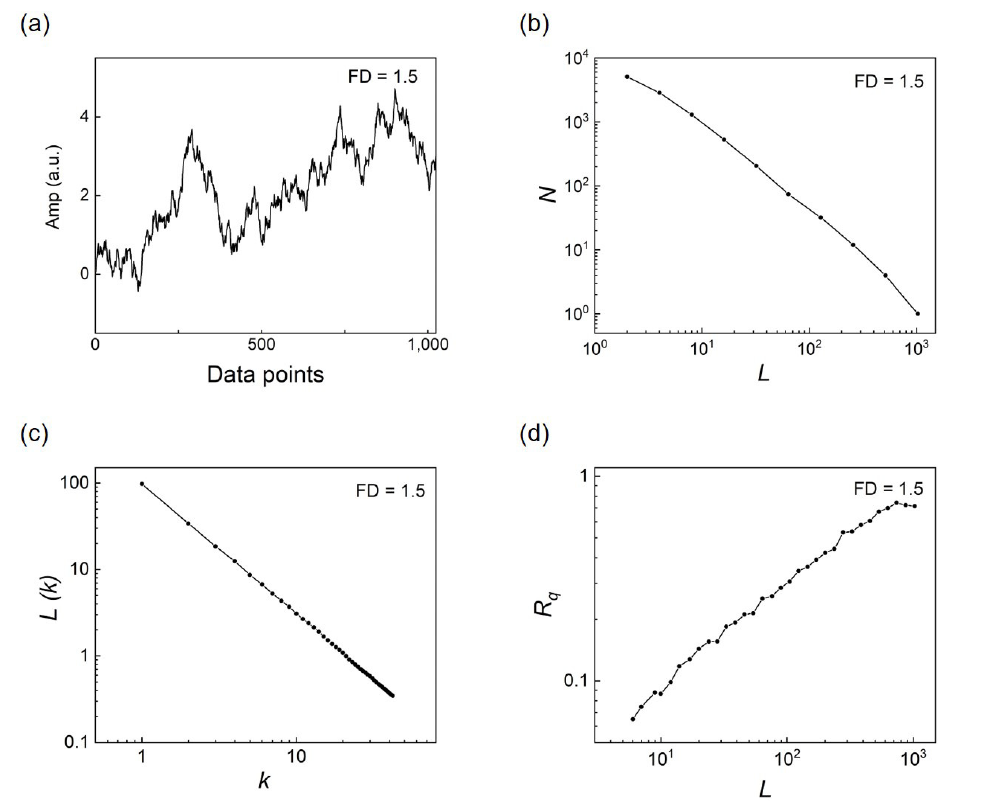
Figure 3. The typical FD evaluation procedures of an artificial profile generated by W-M function shown in ( a ), ( b ) BC method, ( c ) Higuchi method, ( d ) RSE-f1